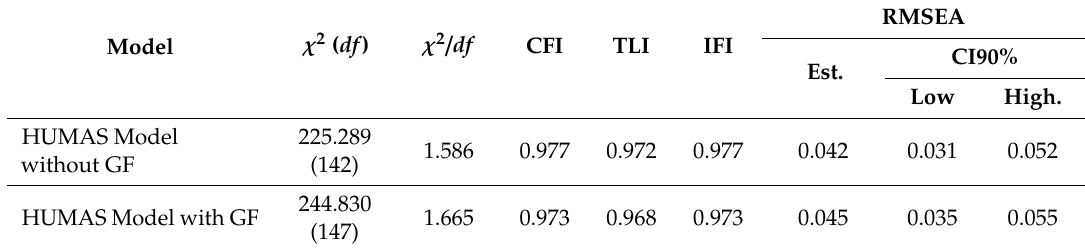
Table 2. Fit indices for the proposed models (calibration sample: n = 330).